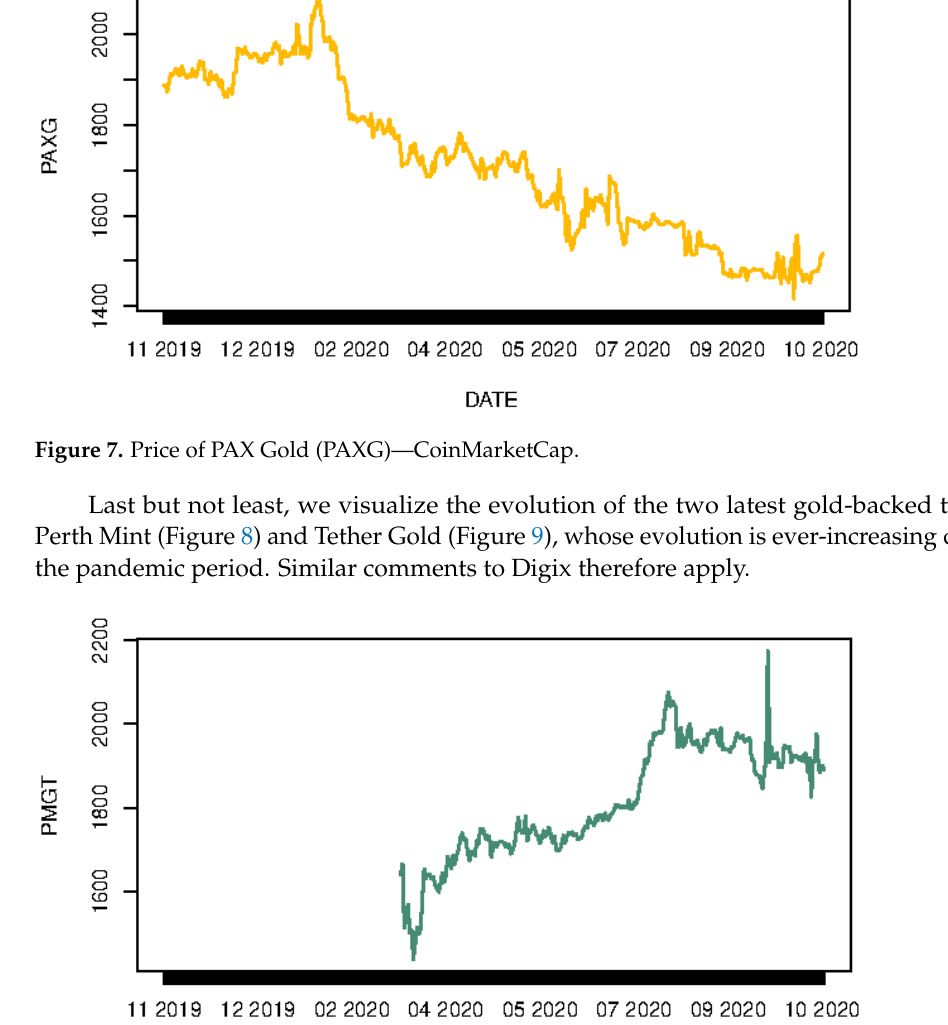
Figure 8. Price of Perth Mint Gold Token